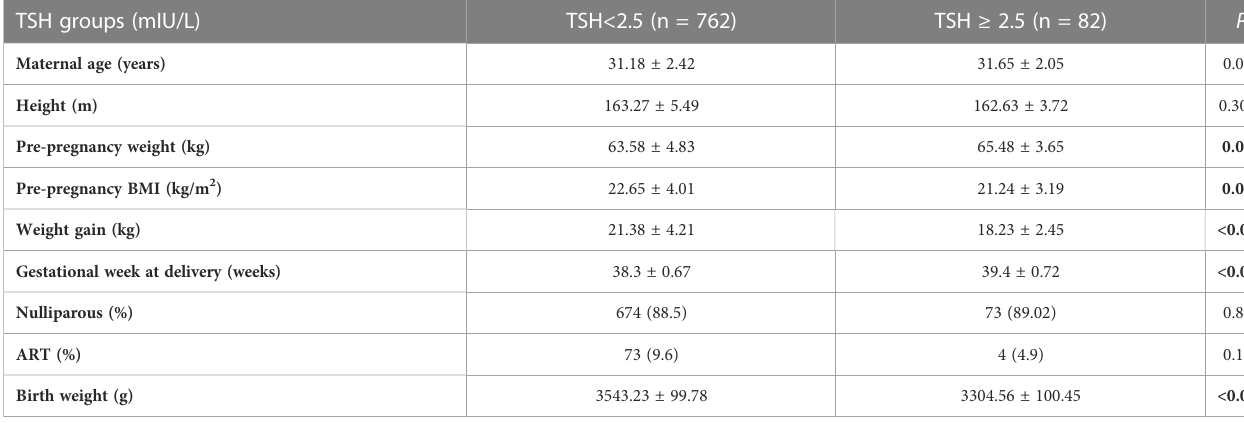
TABLE 2 Clinical and biochemical characteristics of pregnancy by